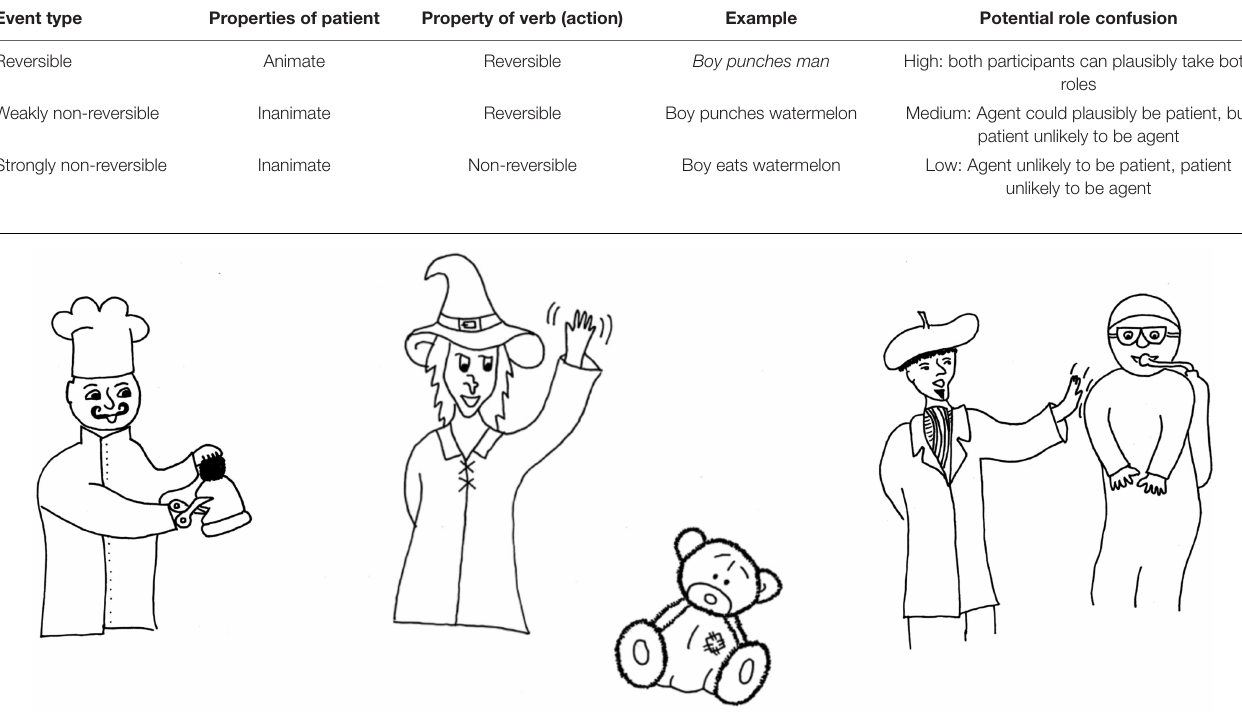
FIGURE 1 | Examples of events used in Experiment 1. From left to right: “Chef cuts hat” (strongly non-reversible), “Witch waves at teddy bear” (weakly non-reversible), and “Artist taps scuba diver”